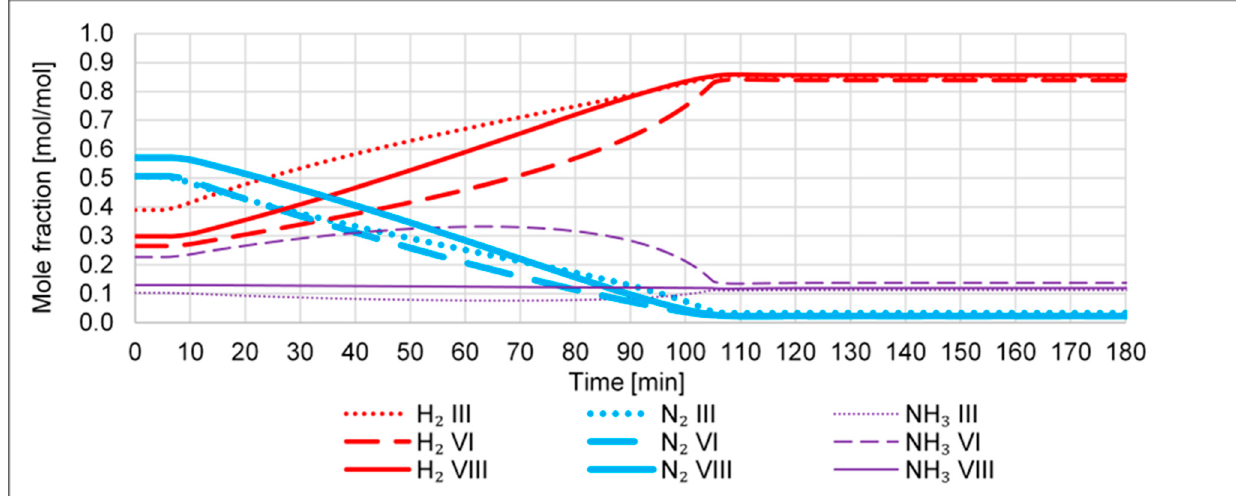
Figure 6 . Selected mole fractions of scenario (b). Figure 6. Selected mole fractions of scenario